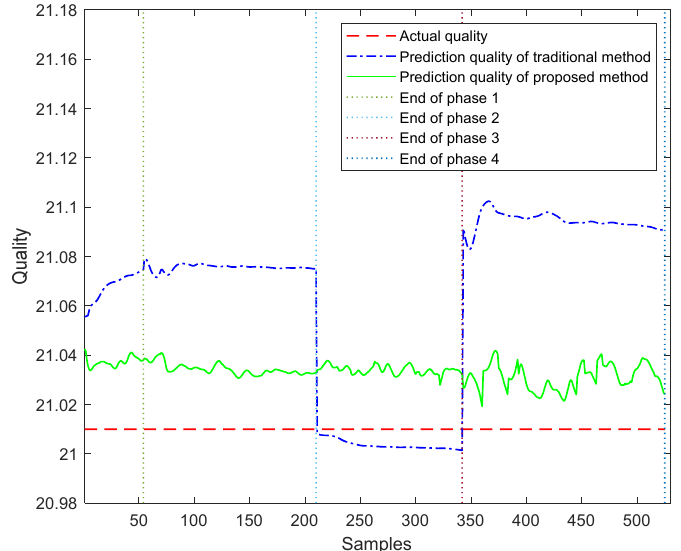
Figure 4. Online quality prediction results of one test batch.